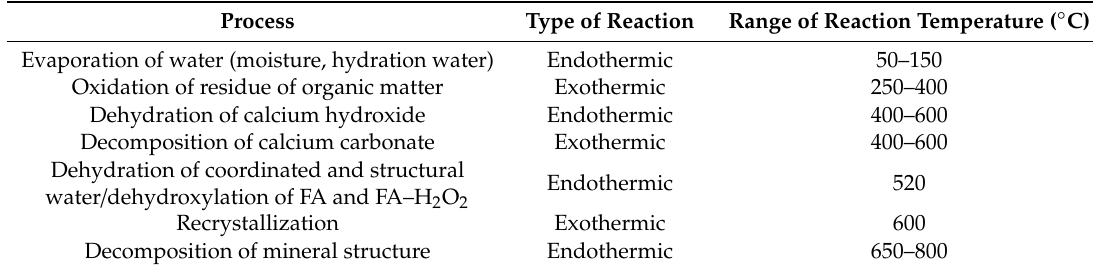
Table 2. Changes in the properties of FA and FA–H 2 O 2 , which occurred as a result of heating during the thermogravimetric analysis.